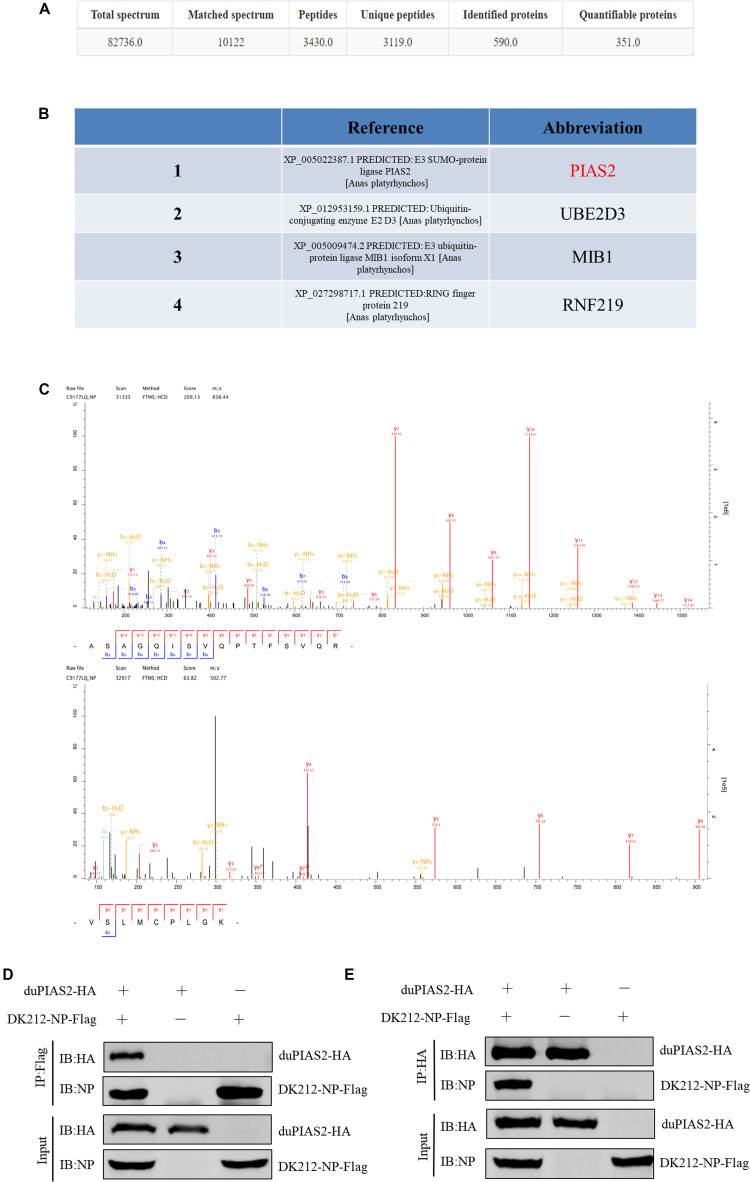
duPIAS2 is identified as a DK212 NP-interacting protein. (A–C) pCAGGS-DK212-NP-Flag or the control vector pCAGGS-eGFP-Flag was transfected into DEF cells. After 36 h, the cells were lysed and immunoprecipitated using anti-Flag agarose beads. The immunoprecipitated protein complexes were identified using LC-MS/MS. (A) Basic statistics for the LC-MS/MS data from pCAGGS-DK212-NP-Flag group. (B) A partial of the identified proteins interacted with DK212 NP using LC-MS/MS. (C) Mass spectrometry of the representative peptides of DK212 NP (upper panel) and duPIAS2 (lower panel). (D,E) duPIAS2 interacted with DK212 NP in transfected cells. HEK 293T cells were transfected with pCAGGS-duPIAS2-HA and pCAGGS-DK212-NP-Flag. After 36 h, the cells were lysed and immunoprecipitated using anti-Flag agarose beads (D) or anti-HA agarose beads (E). The interaction was detected by Western blot using an anti-HA and anti-Flag antibody.